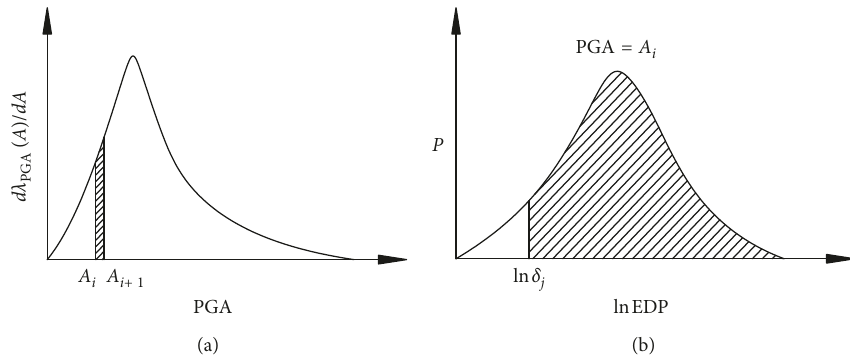
Figure 15: (a) Probability distribution of PGA and (b) probability distribution of EDP under PGA � A 0.0010.010.11